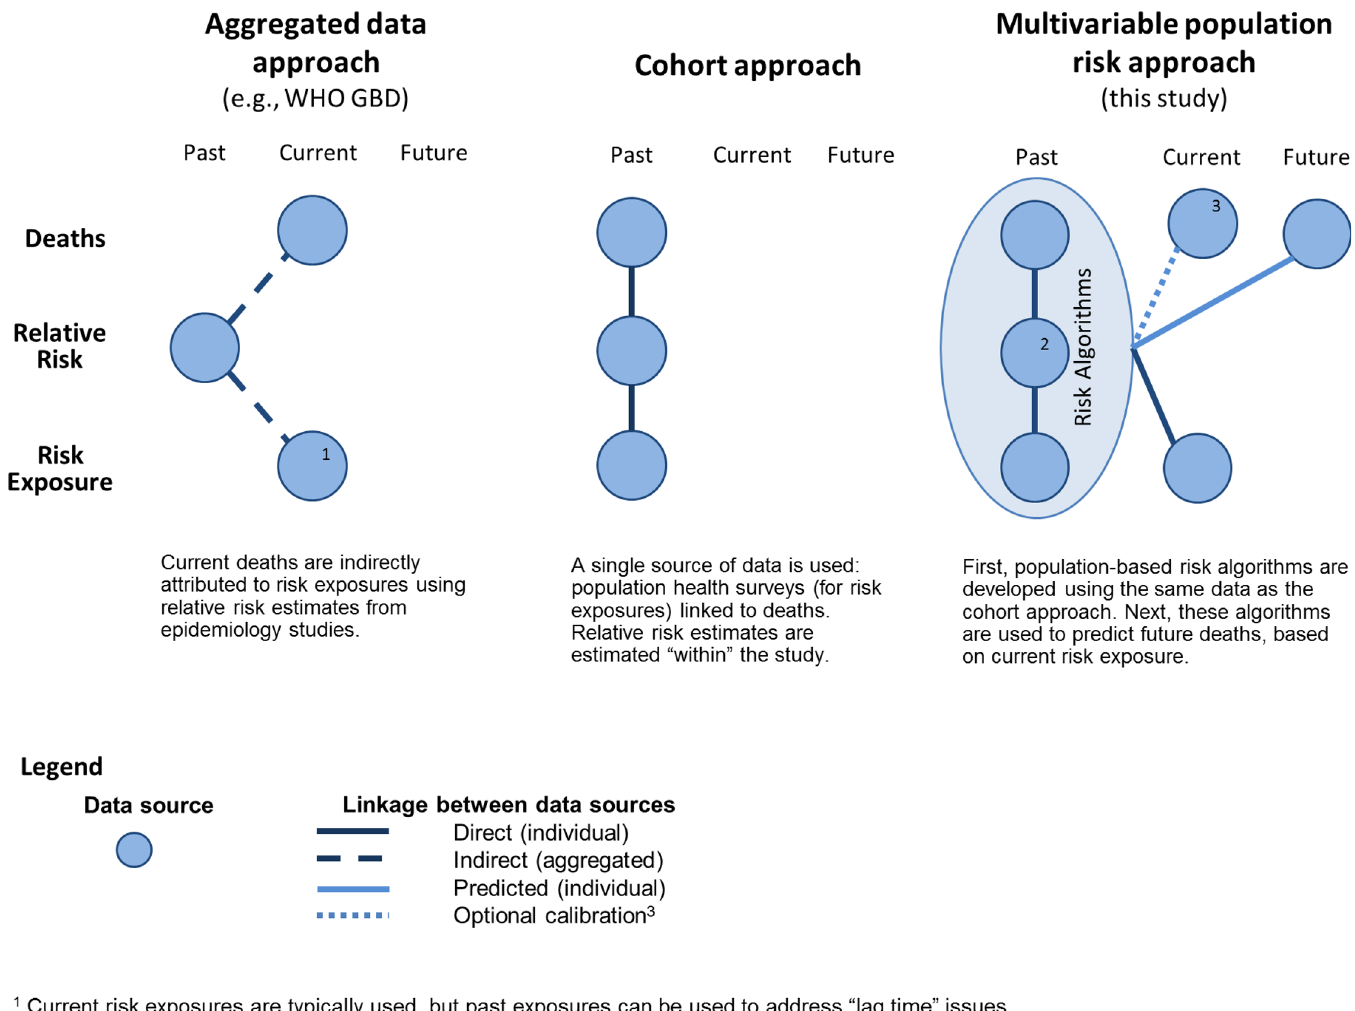
Fig 4. Comparison of approaches to estimate health behaviour